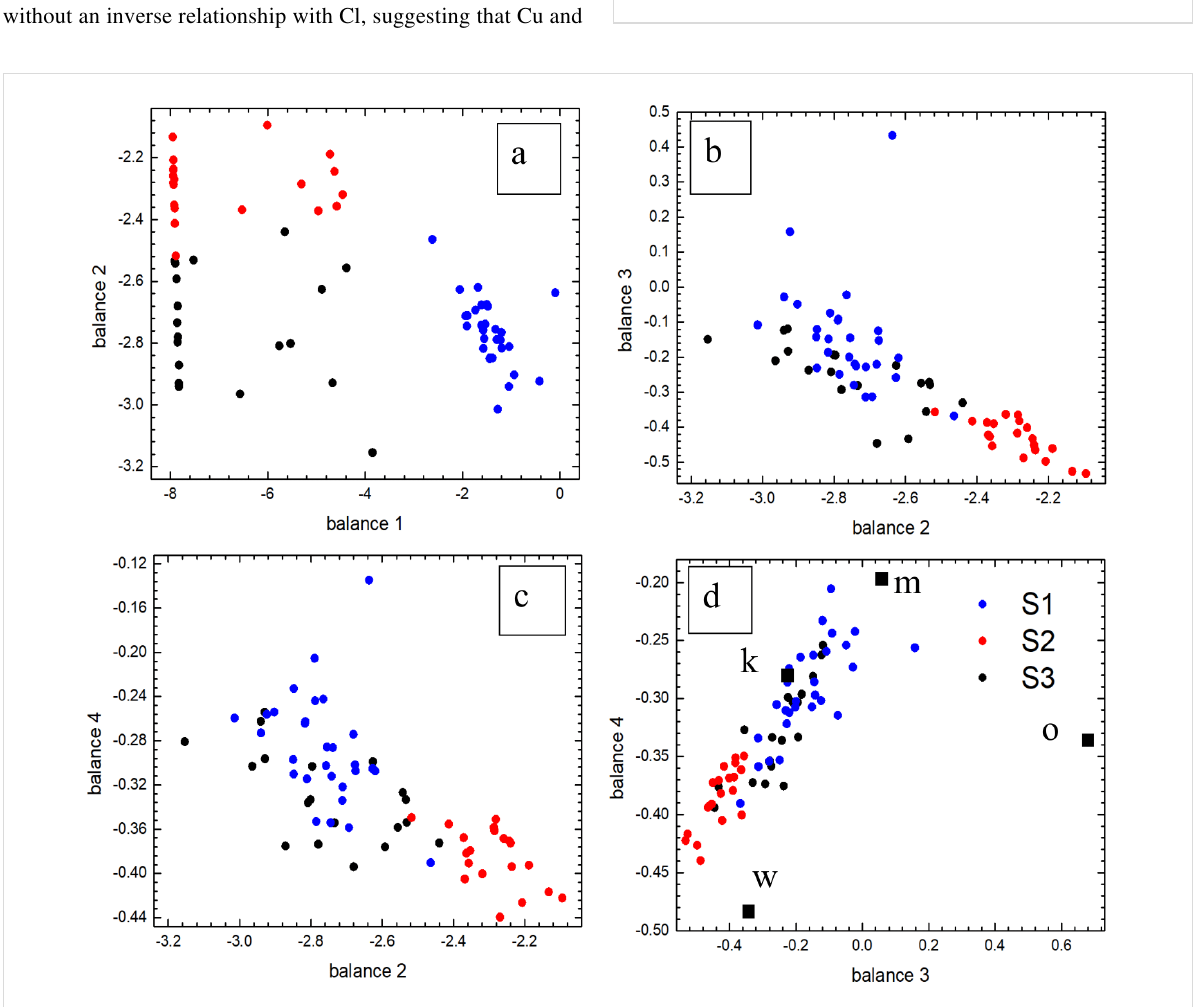
Figure 2: Plot of the trends between two difference balances, where the squares represent the position of the considered phases in the transformed space k) Cu 3 SnS 4 , m) Cu 2 SnS 3 , w) Cu 4 SnS 4 and o) Cu 4 Sn 7 S 16 . Sample S1, S2 and S3 compositions are indicated by blue, red and black dots re- spectively.